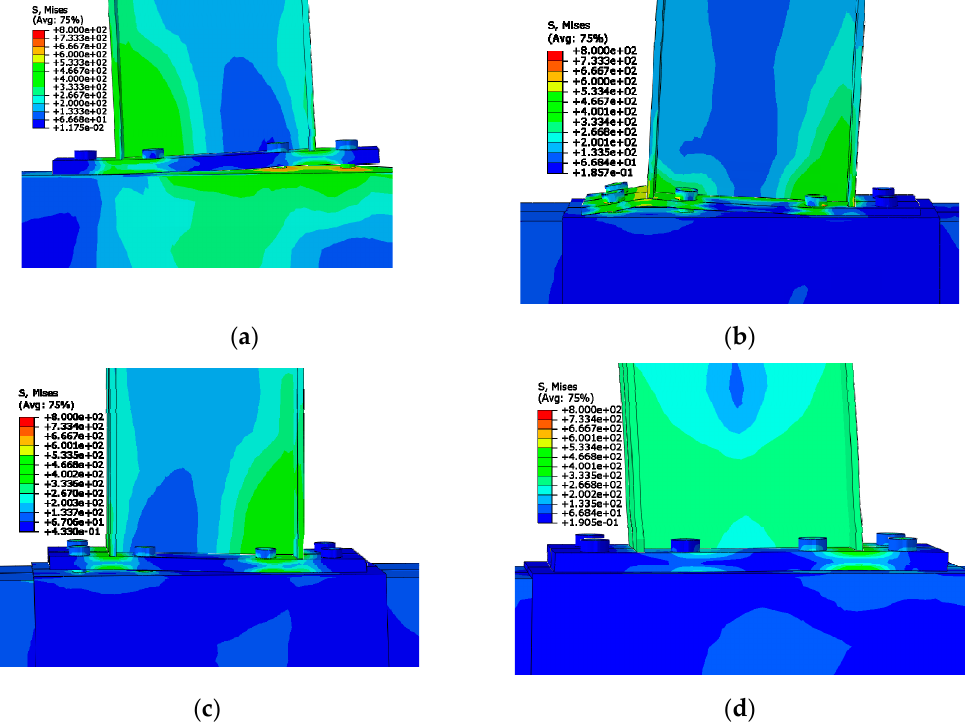
Figure 26. Predicted failure modes of the specimens. ( a ) Specimen SJ-2; ( b ) Specimen SJ-3; ( c ) Specimen SJ-4; ( d ) Specimen SJ-8.